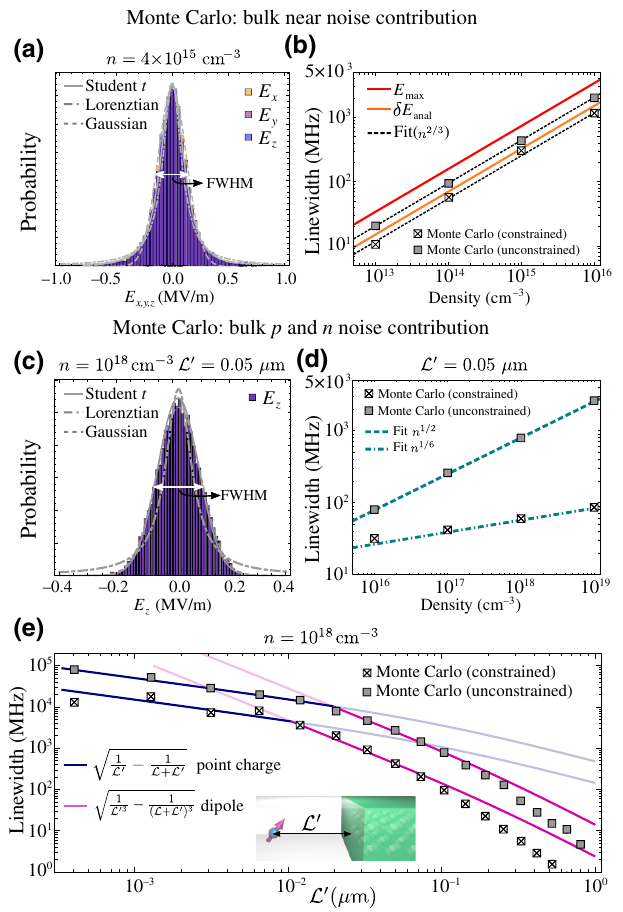
FIG. 6. (a) Electric field histogram due to the bulk near noise contribution with electronic density n = 4 × 10 15 cm − 3 . (b) Bulk near noise FWHM linewidth as a function of density n for con- strained and unconstrained electrons’ positions. The dashed lines are fits showing their n 2 / 3 density dependence, and the orange (red) line is the plot of the analytical result given by Eq. (36) [Eq. (38)] (c) Electric field histogram due to the bulk n noise contri- bution for electronic density n = 10 18 cm − 3 and L (cid:5) = 0.05 μ m. (d) Bulk n noise FWHM linewidth as a function of density n for constrained and unconstrained electrons’ positions for L (cid:5) = 0.05 μ m. (e) Bulk near n noise FWHM linewidth as a function of L (cid:5) for n = 10 18 cm − 3